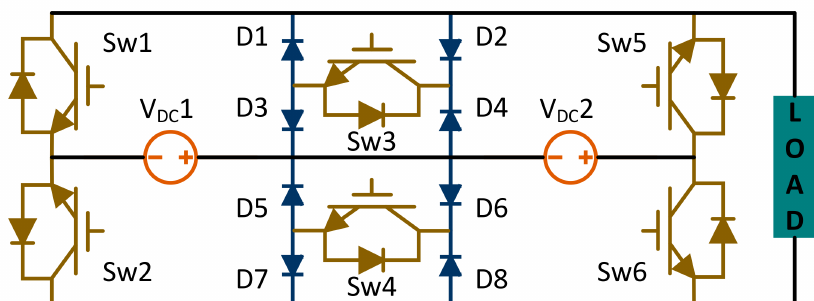
Figure 24. Topology of Mokhberdoran multilevel inverter.